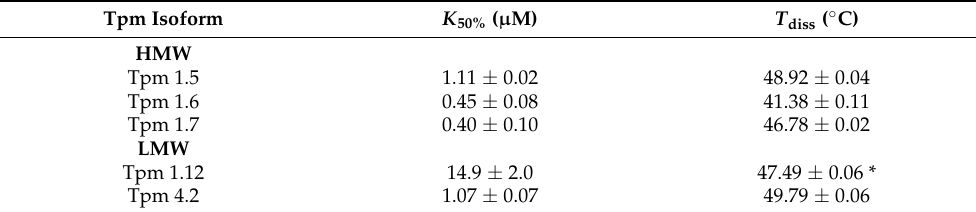
Table 2. Actin binding properties of various Tpm isoforms and the thermal stability of Tpm–F-actin